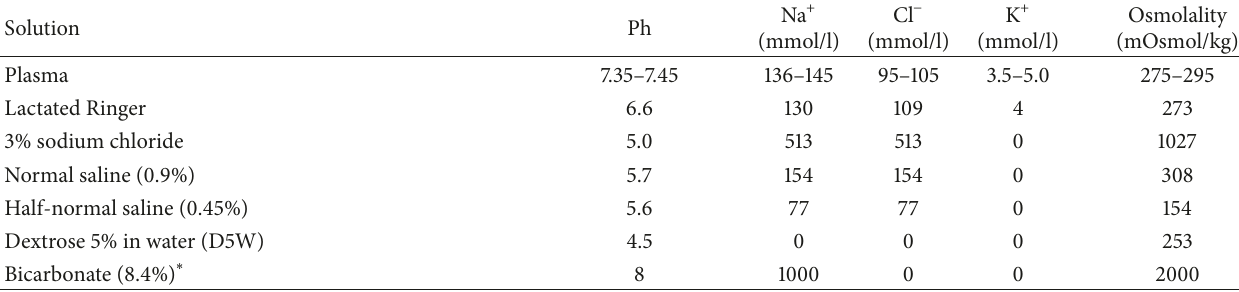
Table 1: Constituents and characteristics of commonly used crystalloids and plasma.